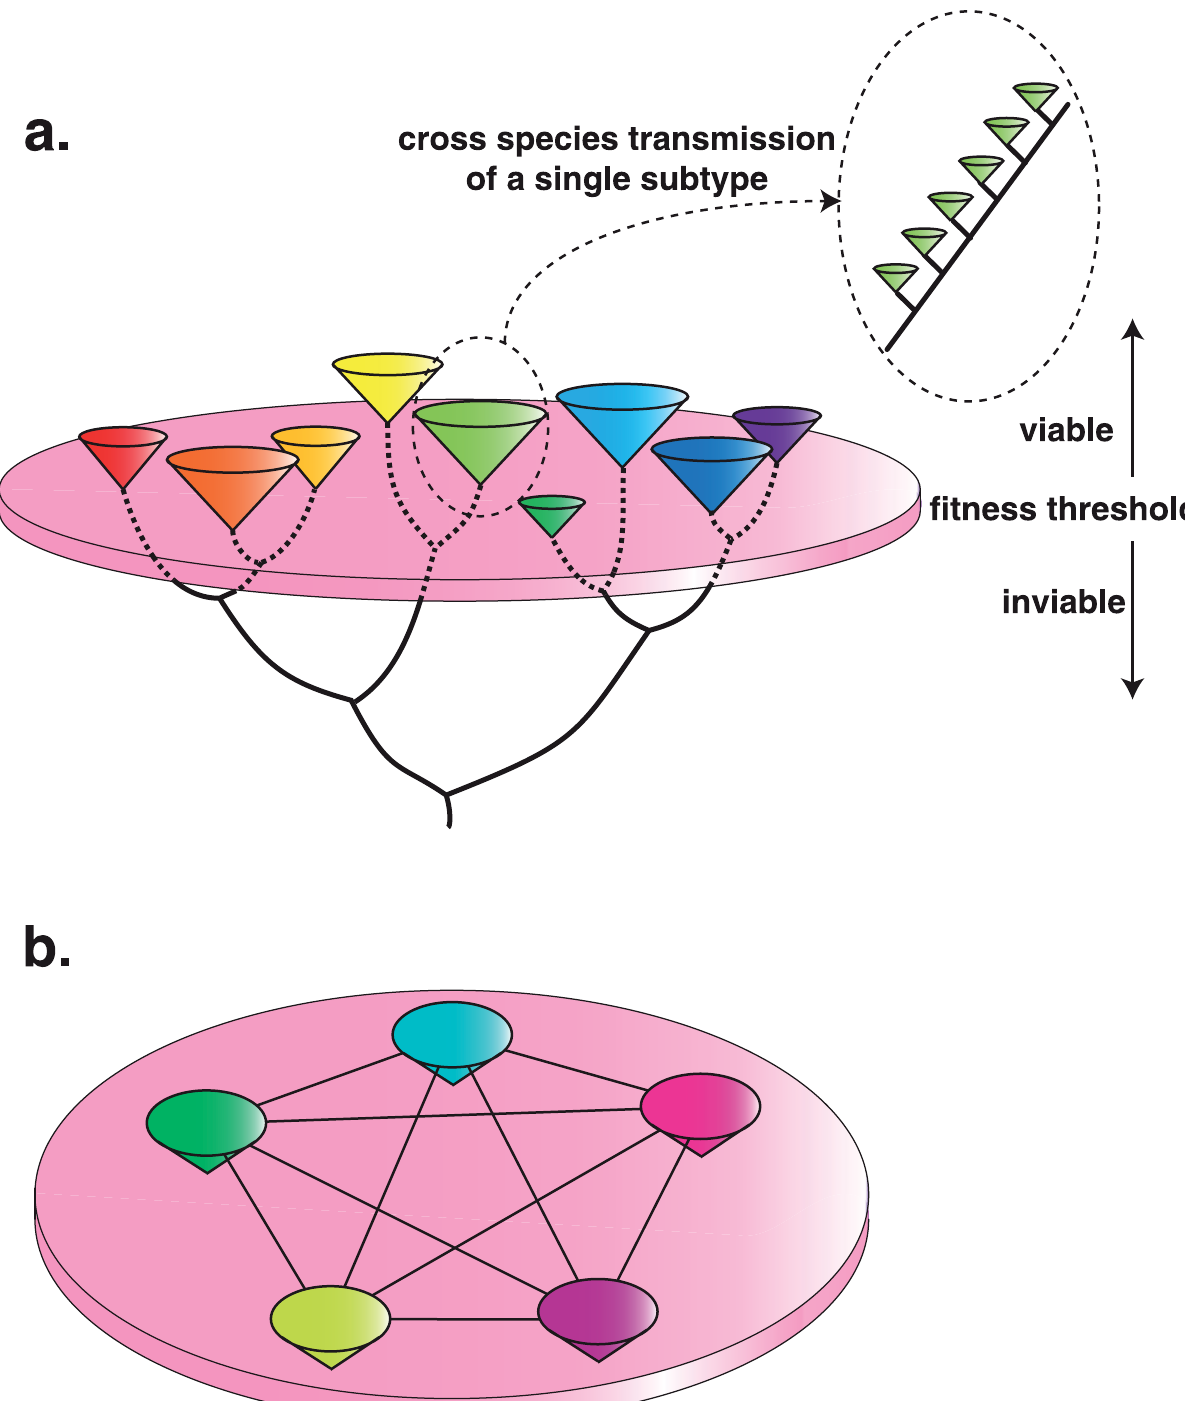
Figure 4. The fitness landscapes of avian influenza virus. (a) The fitness landscapes observed in HA, NA and NS, and represented here by NA. Each colored cone represents an individual subtype. These subtypes are connected by a bifurcating tree. The lack of ‘intermediate’ subtypes – those falling below the pink disc – reflects major valleys in fitness, such that any virus falling in this area will experience a major reduction in fitness, most likely due to an elevated cross-protective immune response. Occasionally, individual subtypes jump species barriers and spread in new hosts (such as humans), where they experience a continued selection pressure and hence accumulate amino acid substitutions in a progressive manner, as shown. (b) The fitness landscapes observed in the remaining internal protein segments of avian influenza virus – PB2, PB1, PA, NP and M (represented by different colors). In this case, there is little functional difference among the genetic variants of each segment, so that the fitness landscape is flat. This equivalence in fitness among genome constellations also means that reassortment is frequent among them (as reassortants suffer no fitness cost), represented by the horizontal lines connected each internal gene segment.